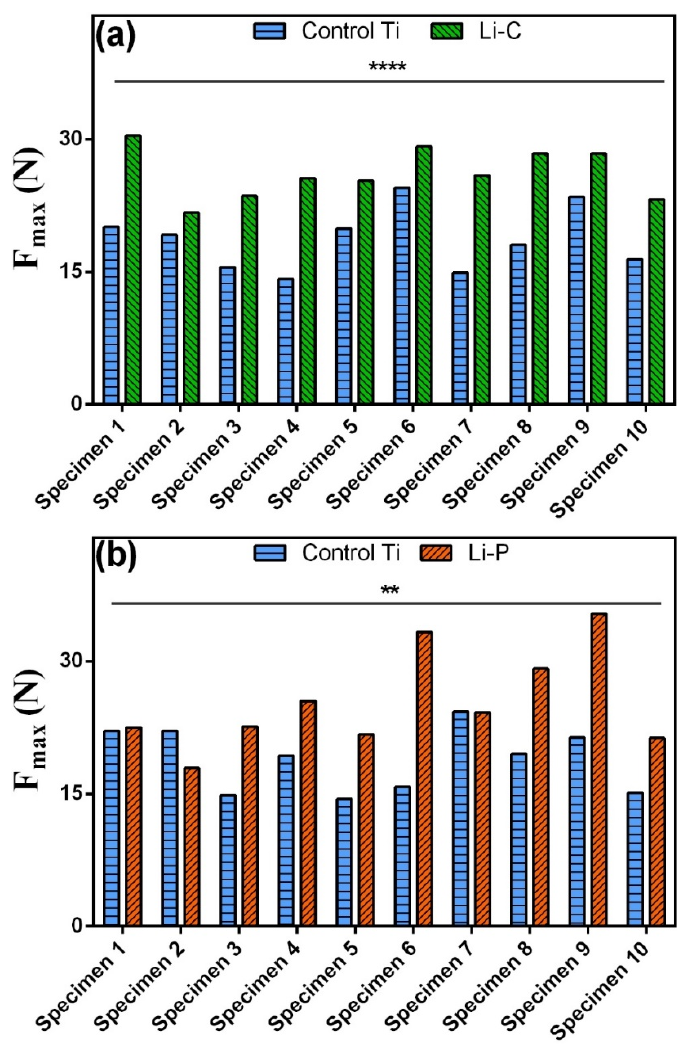
Figure 6. Detachment force, F max , of implants ( n = 10) under tensile pull-out testing, inferred in the case of control 3D Ti implants (marked in blue color) and of those functionalized with ( a ) Li-C (marked in green color) and ( b ) Li-P (marked in orange color) coatings, at 4 weeks after surgery. **** Represents highly significant differences ( p ≤ 0.0001). ** Represents significant differences ( p ≤ 0.01).